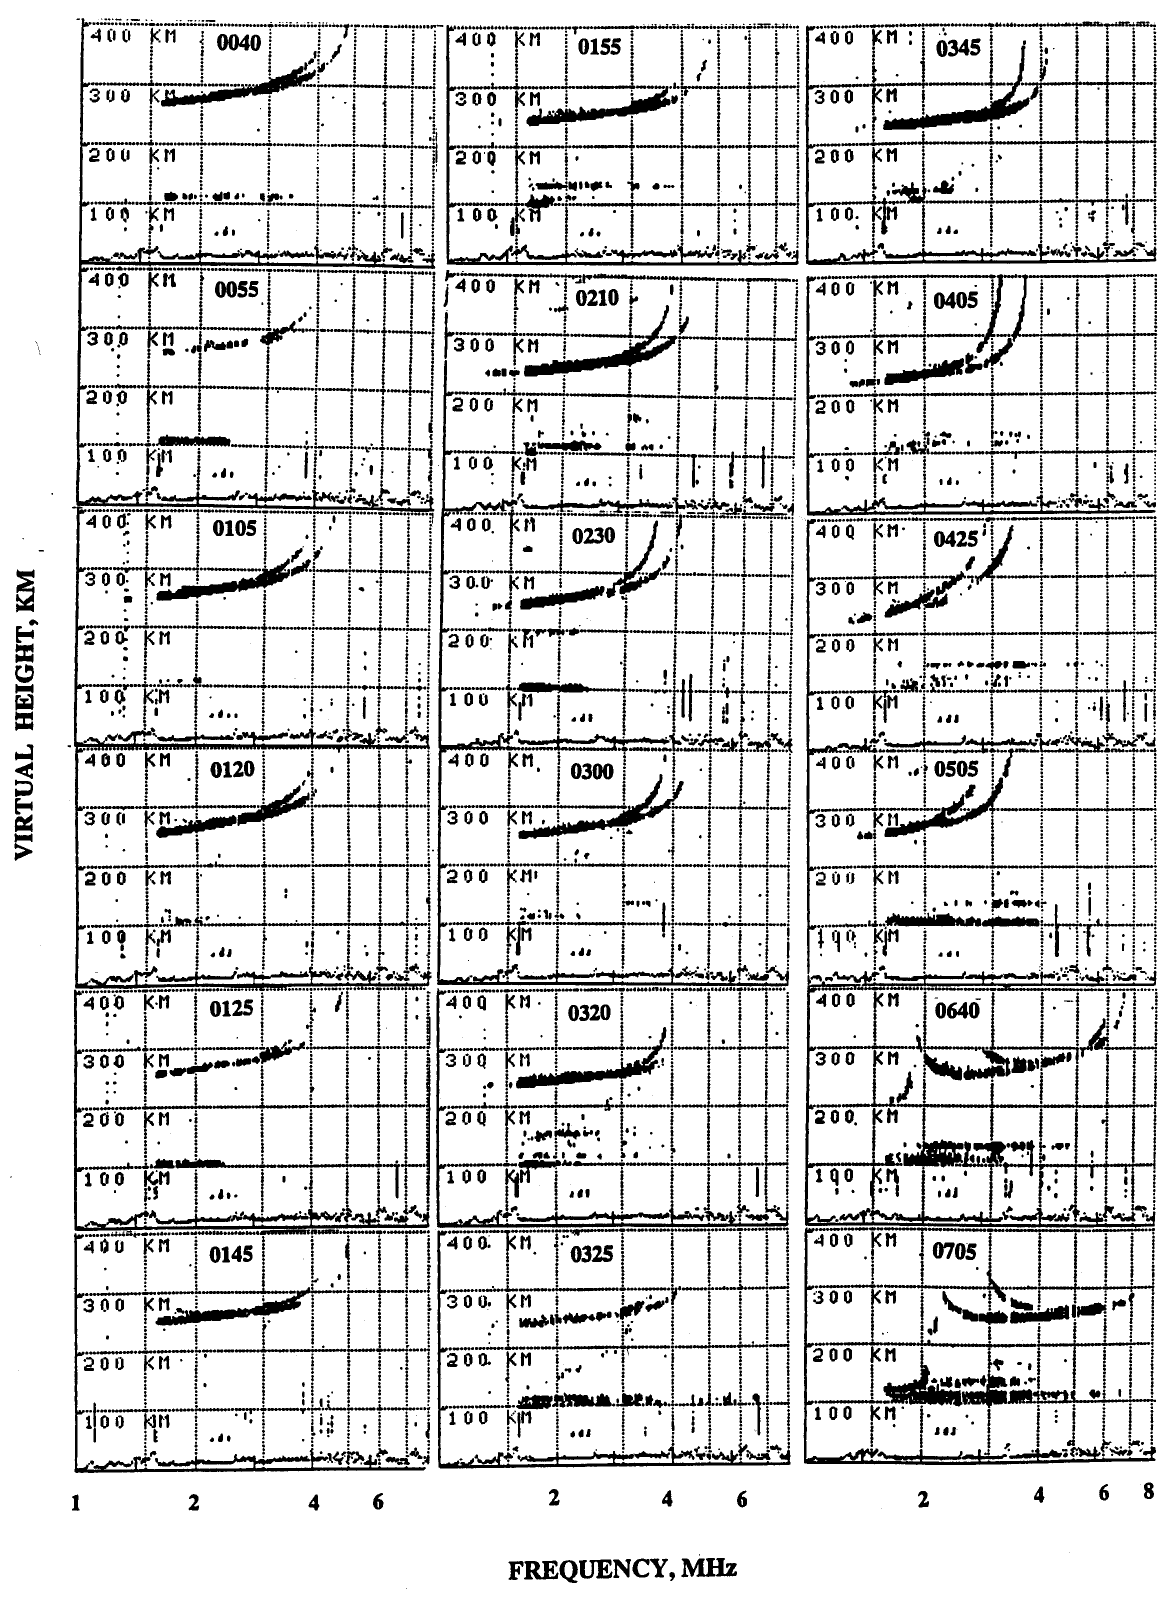
Fig. 5. Selected ionograms over Ahmedabad from 0040 to 0705h of 17 November 1998 showing the development of sporadic-E associated with Leonid shower